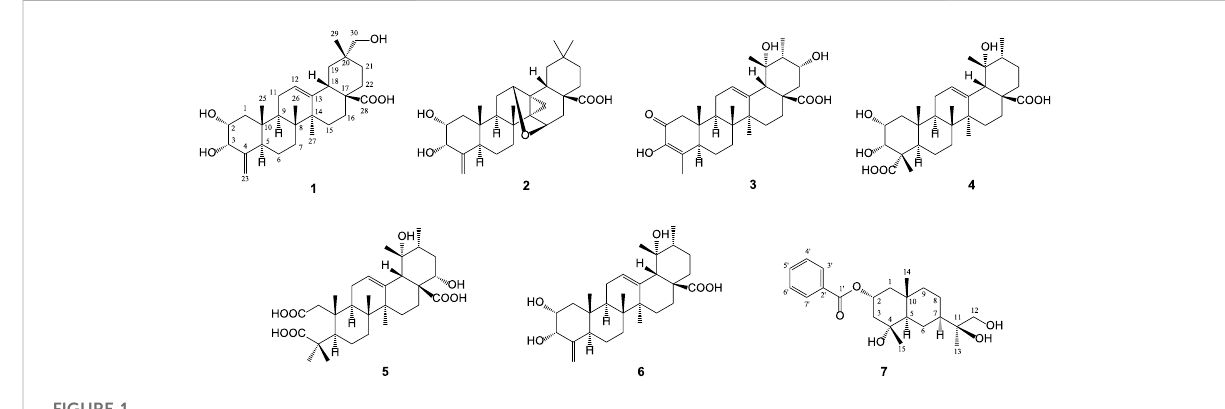
FIGURE 1 Chemical structures of compounds 1 ‒ 7 isolated from M. procumbens